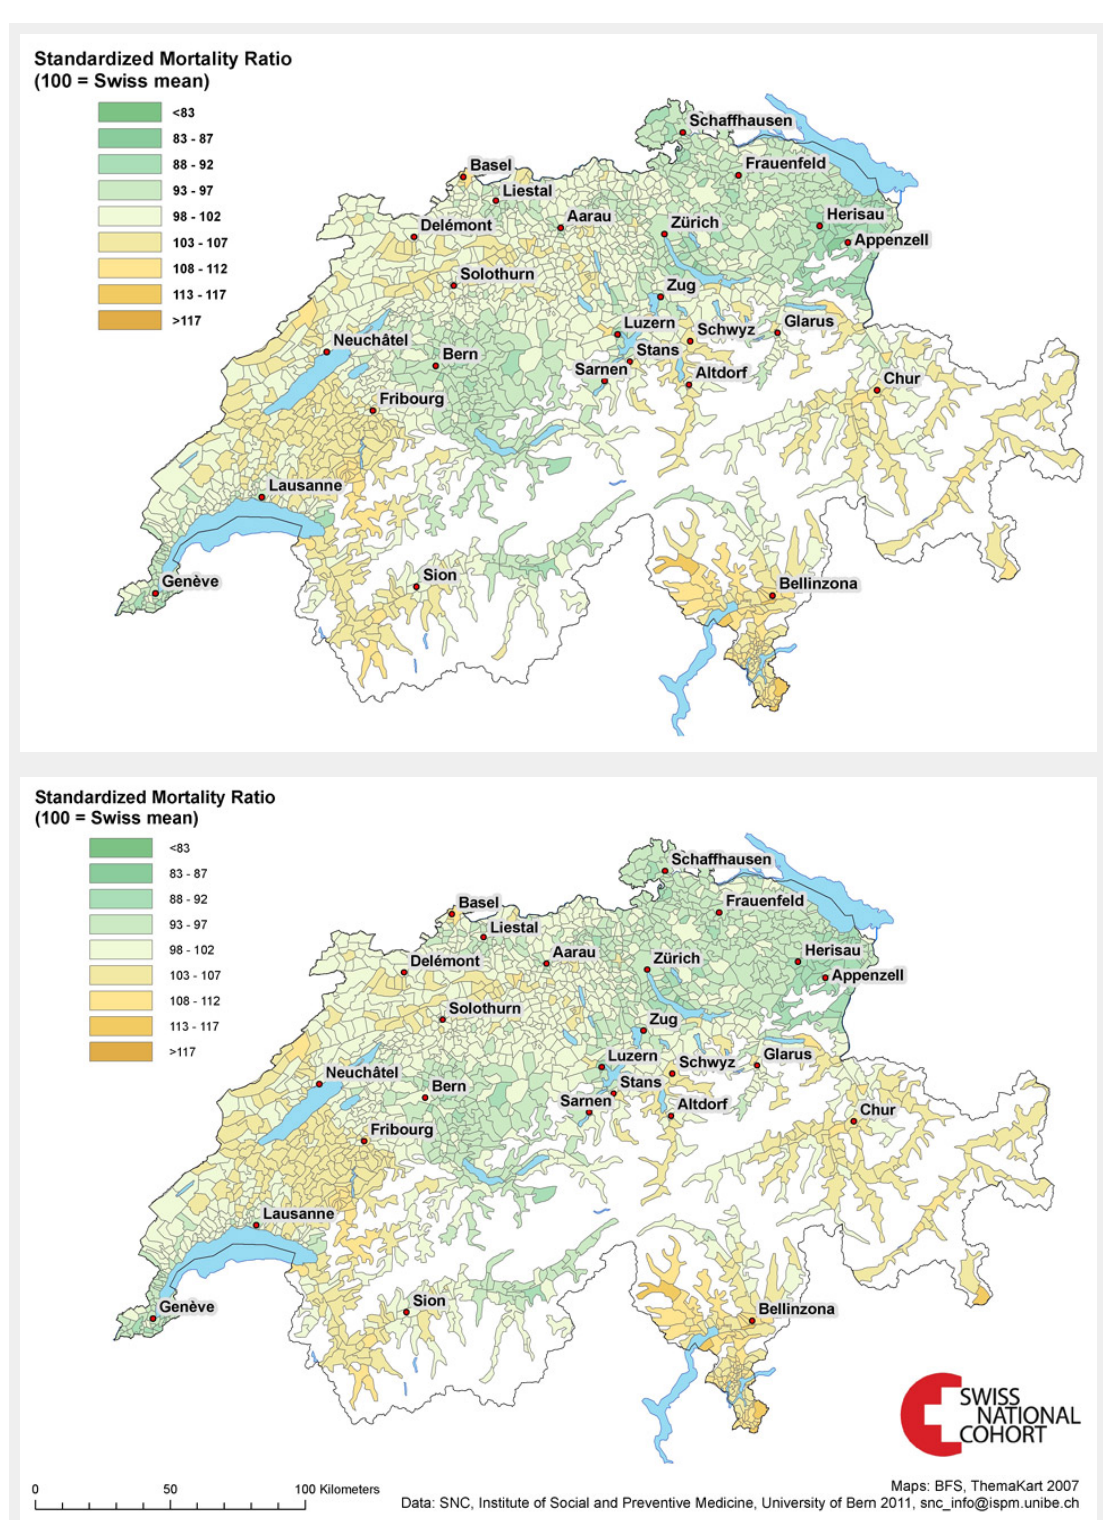
Figure 1 B Map of Switzerland showing standardised cancer mortality ratios for older Swiss women (≥65 years old). © BFS. Reprinted with